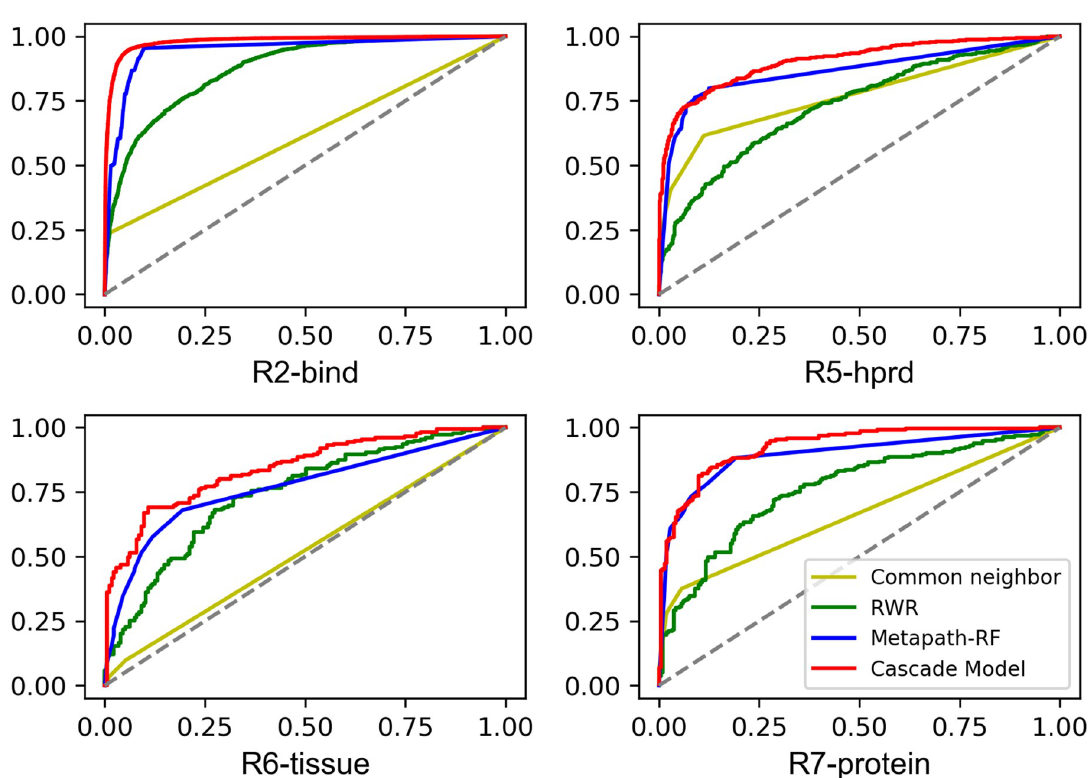
Fig 6. ROC Curve for part of relations on link prediction